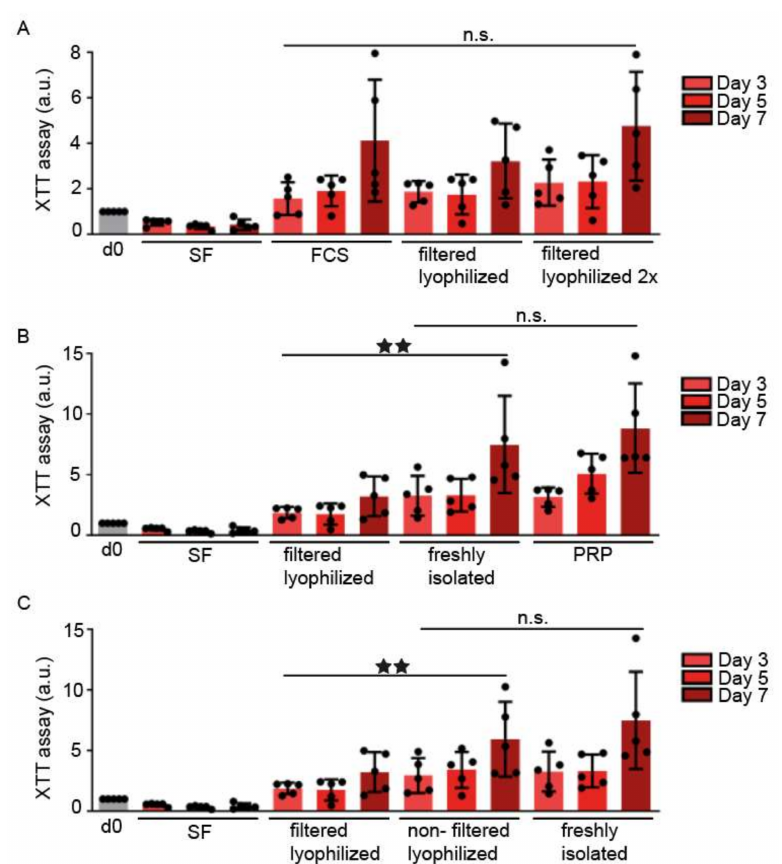
Figure 1. Chondrocyte viability by XTT assay over time (days 3, 5 and 7). Comparisons include ( A ) two concentrations (10% and 20%) of filtered lyophilized HAS (represented as filtered lyophilized and filtered lyophilized 2 × , respectively) and 10% FCS; ( B ) filtered lyophilized HAS, freshly isolated HAS and PRP; ( C ) the two versions of lyophilized (filtered and non-filtered) and freshly isolated HAS. Serum free (SF) and day 0 (d0) were used as negative controls in all experiments (n = 5). Bars represent arithmetic means and error bars show standard deviations (SD). Other abbreviations: not significant (n.s.), arbitrary units (a.u.), fetal calf serum (FCS), level of significance where p < 0.01 (**). To investigate a possible synergistic effect between HA and HAS, HA was supple- mented to the filtered and non-filtered lyophilized HAS formulations. Cell viability mea- surements via XTT assay showed no statistical significance (Table